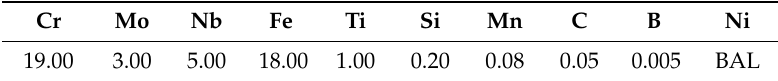
Table 2. Chemical composition (wt %) of the MetcoClad 718 powder [13].